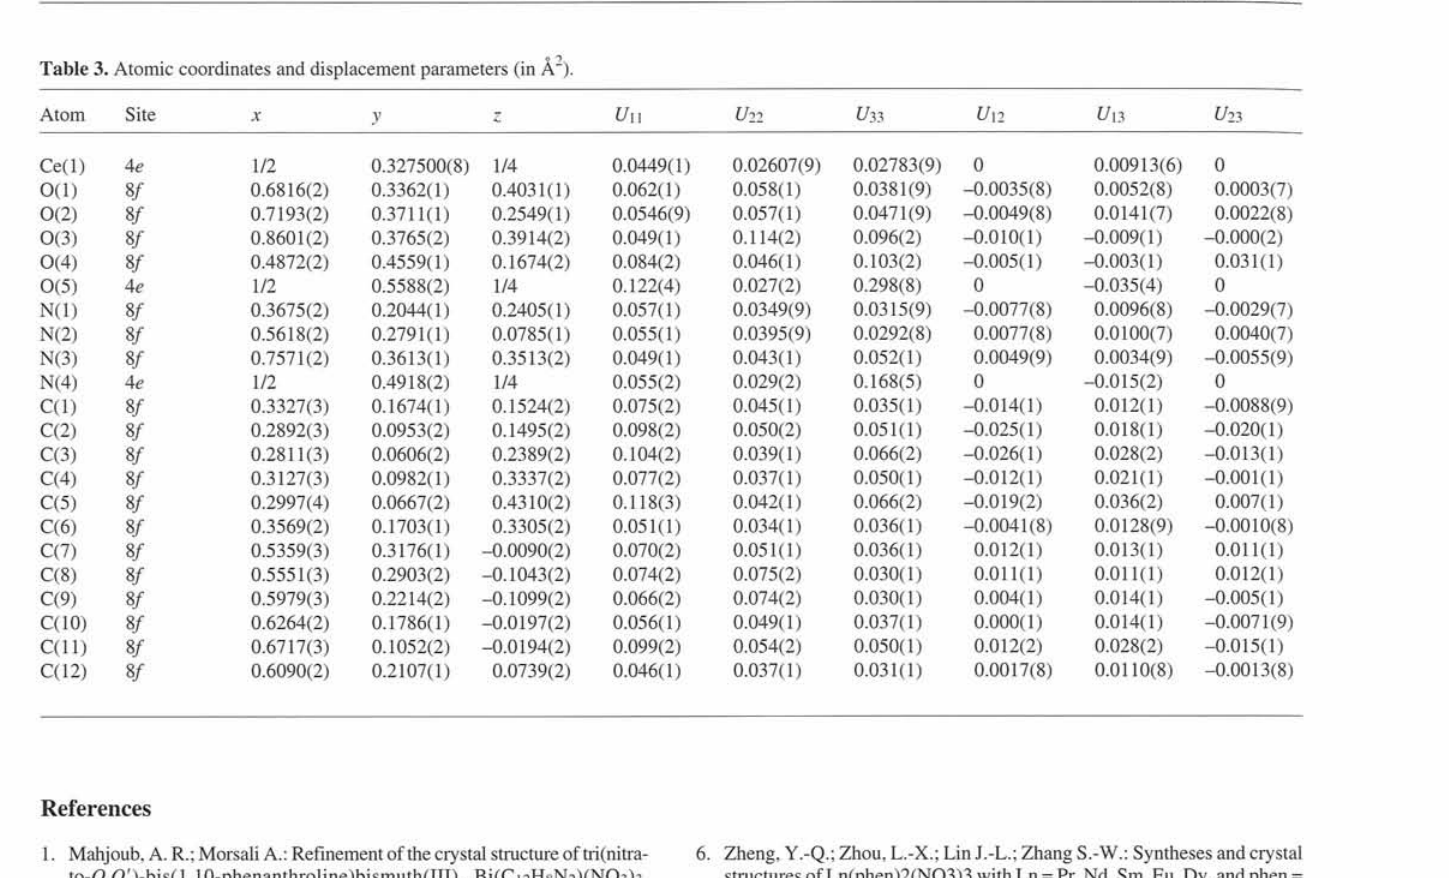
o 2 Table 3. Atomic coordinates and displacement parameters (in A